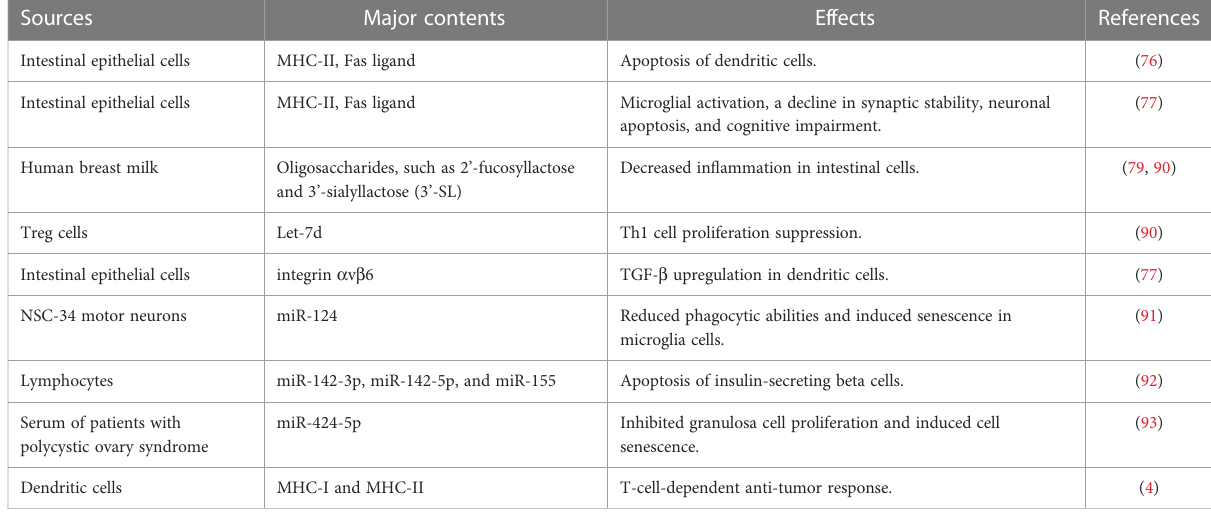
TABLE 2 Contents and functions of the